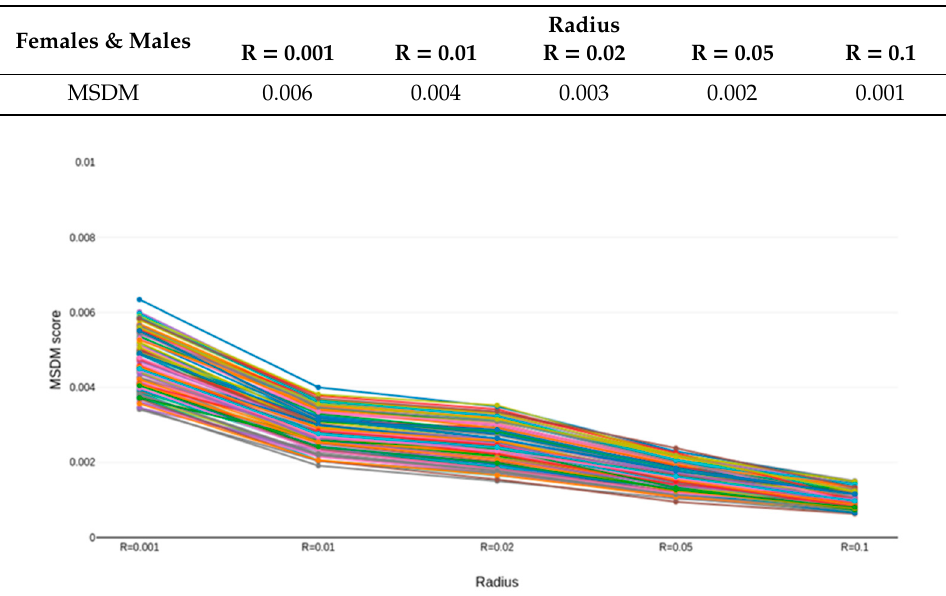
Figure 7. Mean MSDM scores of the testing database for five different radius values.